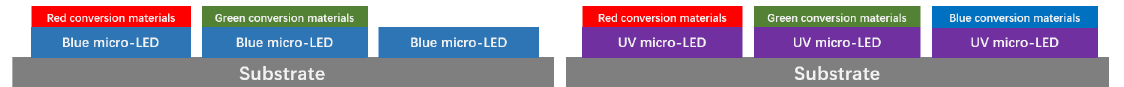
Table 2. Comparison of various mass transfer technologies.